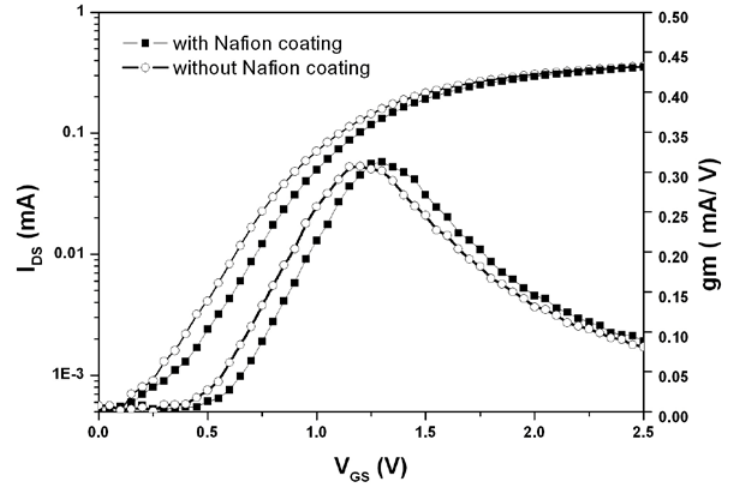
Figure 4. The I without Nafion TM coating.